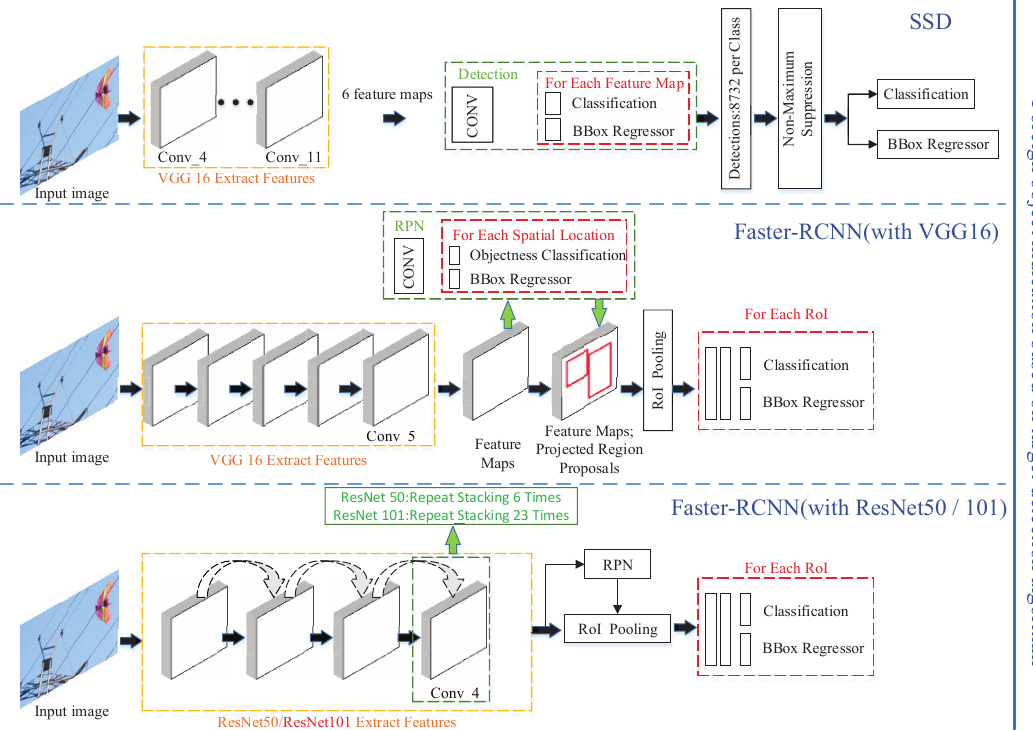
Figure 5. Foreign object indication based on a target detection